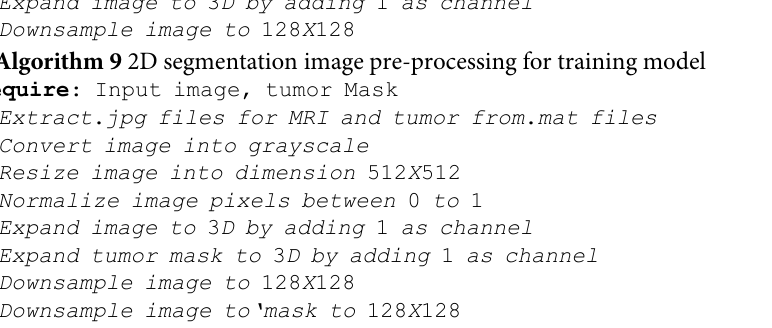
Algorithm 9 2D segmentation image pre-processing for training model